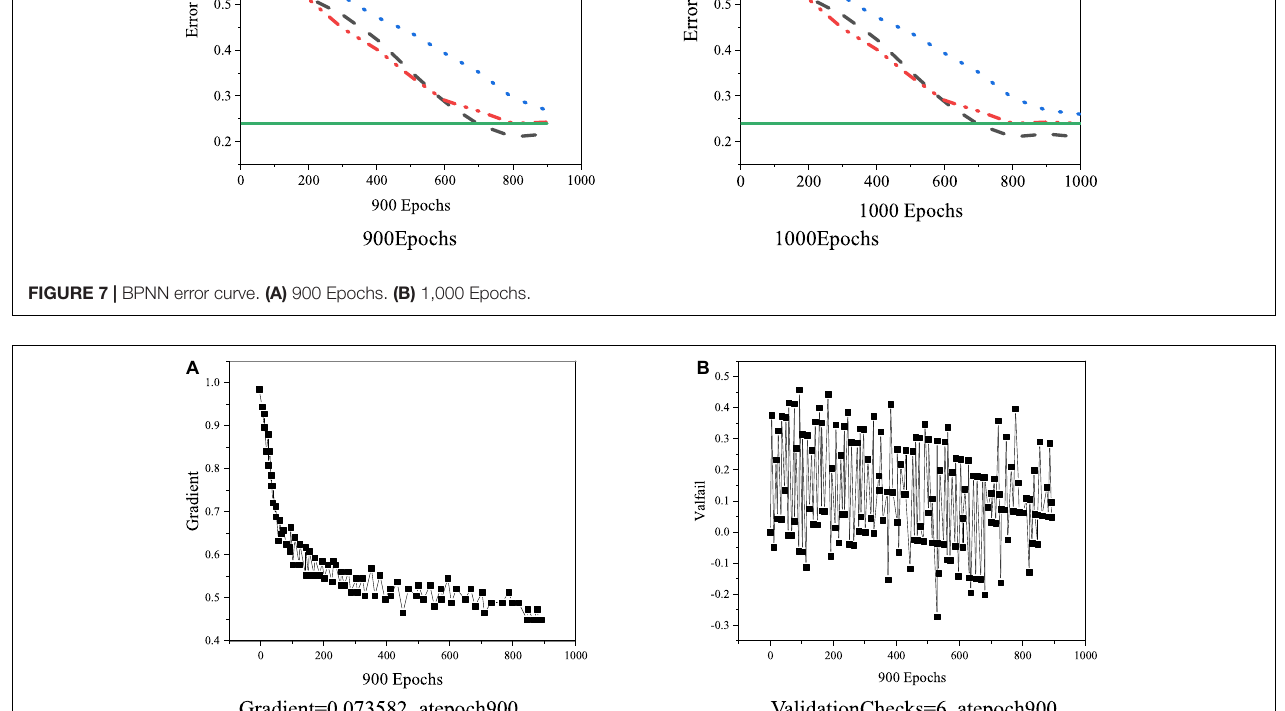
FIGURE 8 | BPNN training status. (A) Gradient = 0.073582, atepoch 900. (B) ValidationChecks = 6, atepoch 900.